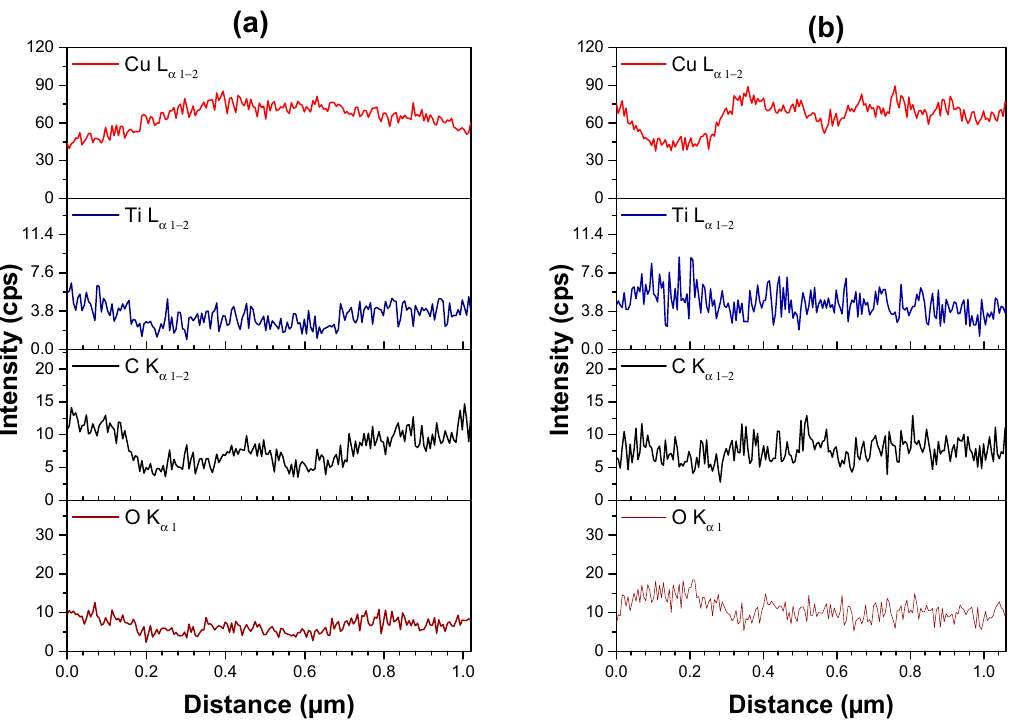
Figure 9. SEM images and EDS profiles for ( a ) Cu–TiH2–C and ( b ) Cu–Ti–C composites sintered at 1000 °C with 10 vol % reinforcement particles.